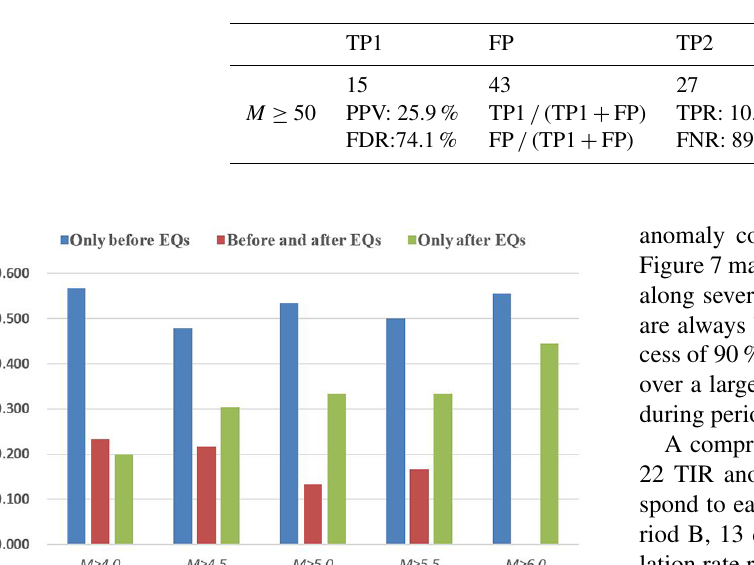
Table 2. Statistical results of earthquakes with M ≥ 50.